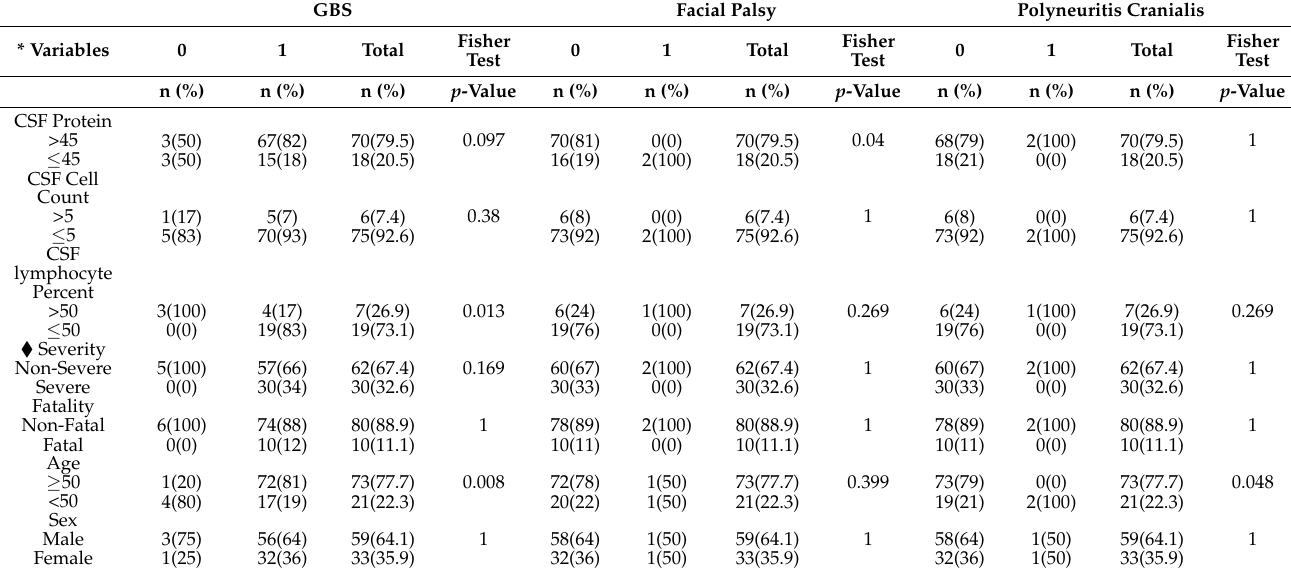
Table 9. Comparison of various CSF markers, demographics, severity and fatality by PNS manifestation. GBS Facial Palsy Polyneuritis